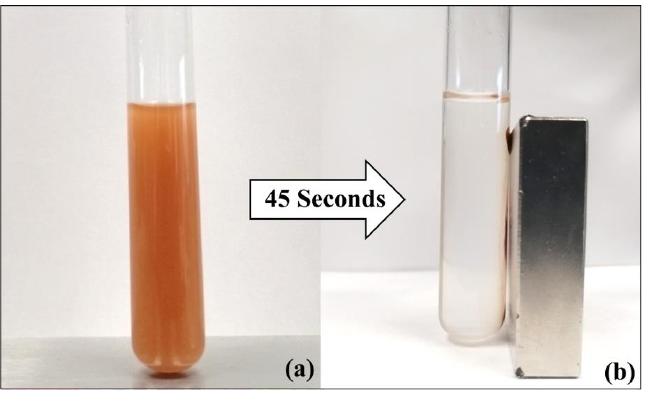
Figure 6. MNPsFe 3 O 4 -SiO 2 -poly (NVCL-co-MAA), before ( a ) and after 45 s ( b ) of the application of a magnetic field.